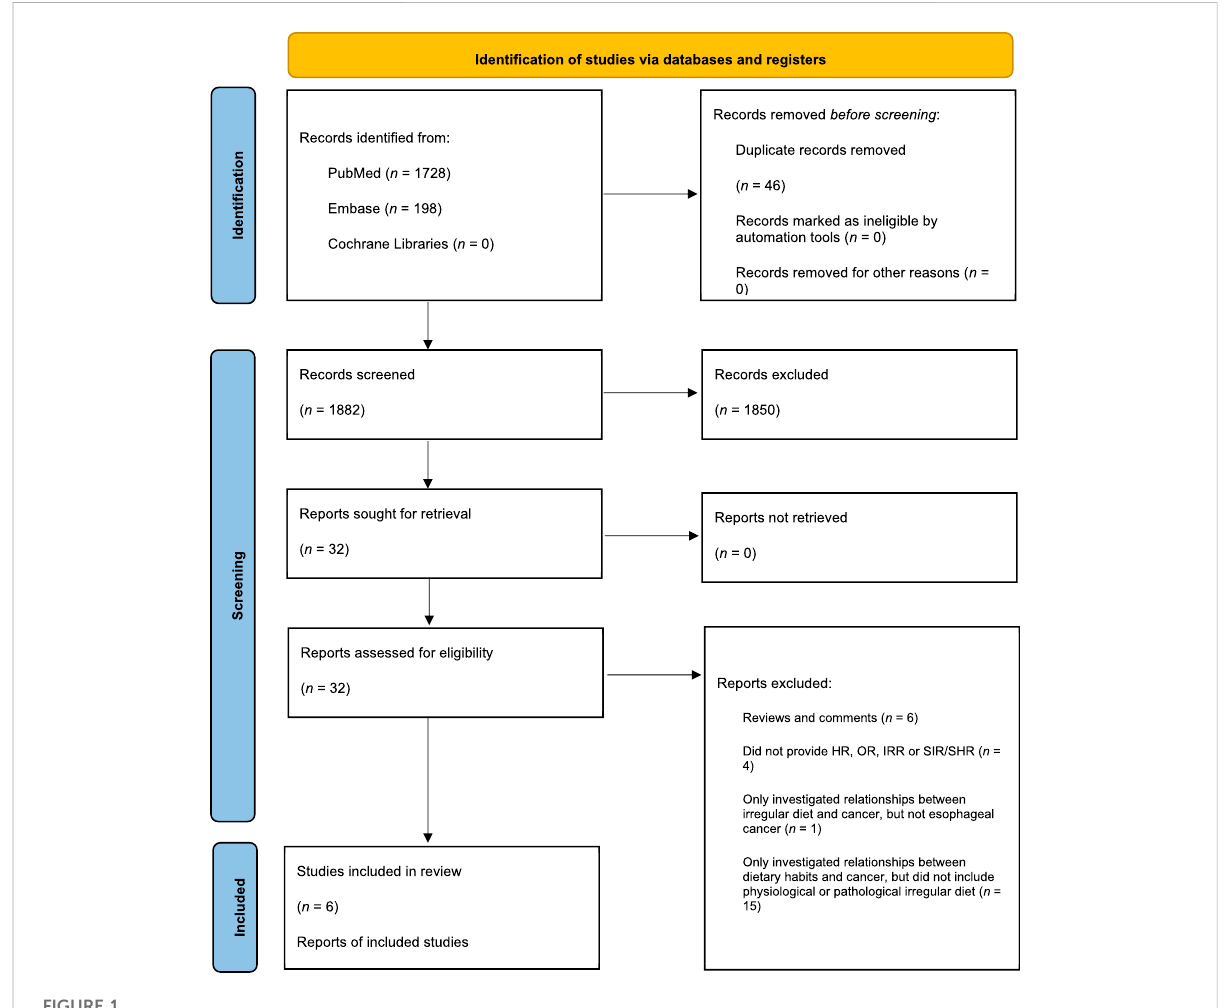
FIGURE 1 Study selection